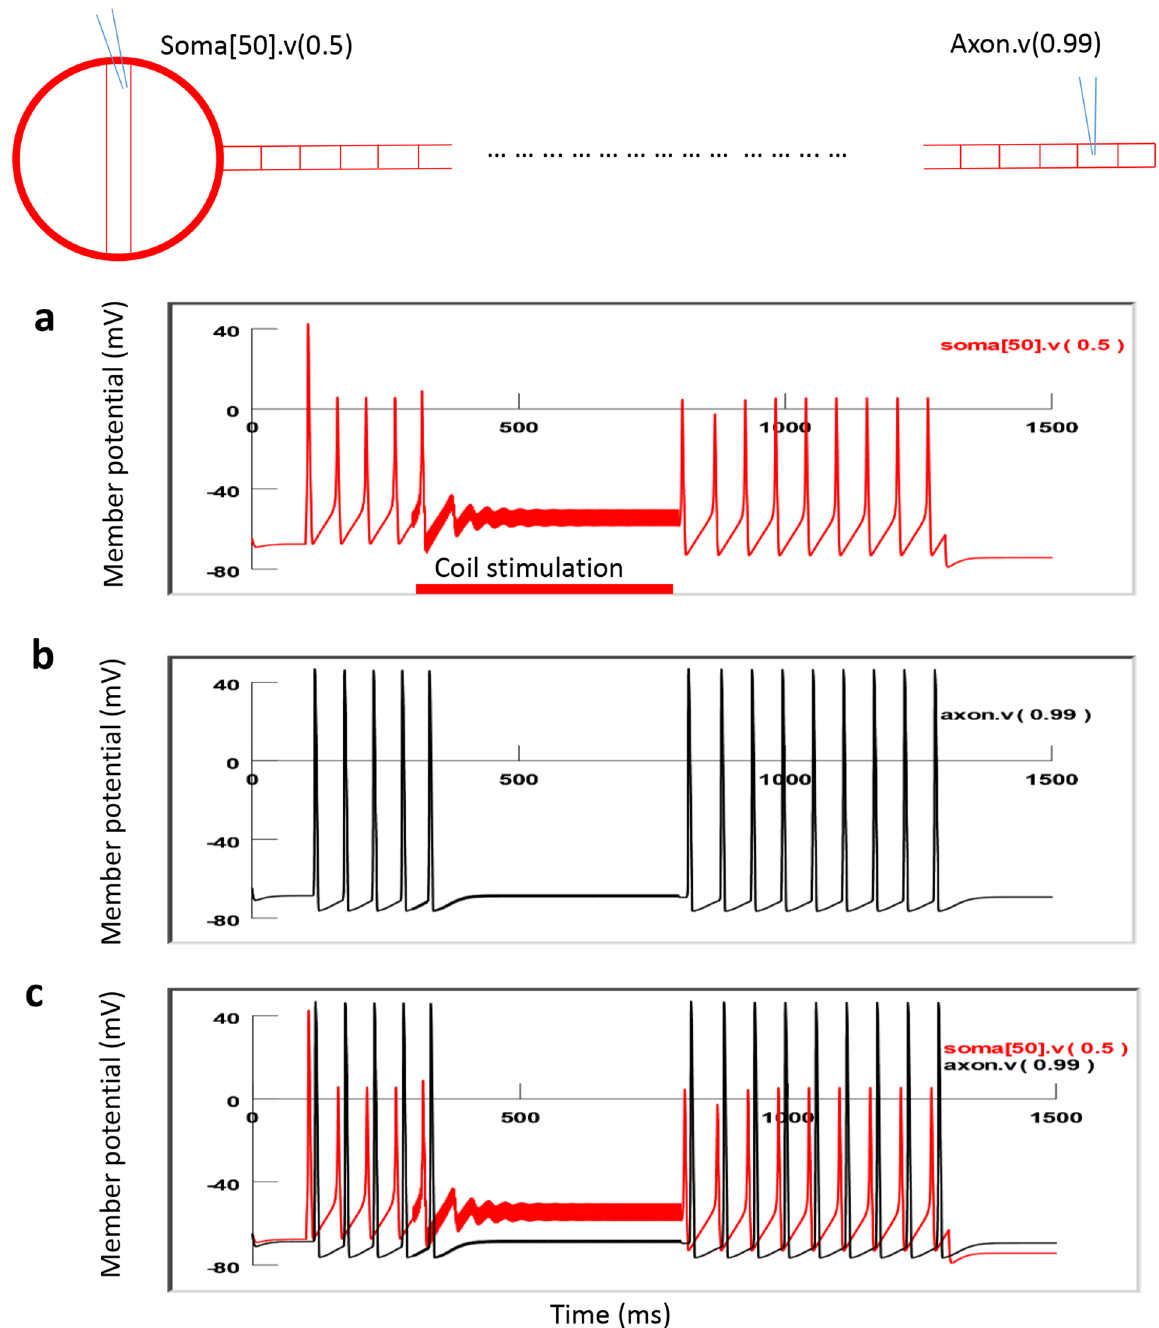
Figure 10. HFS with miniature magnetic coil inhibited soma activity and blocked neuron output in the modeled axon. The miniature coil was positioned at (− 1000, 300). A depolarization current was injected into the soma to trigger action potentials. A 500 ms train of biphasic square pulses (400 Hz) was applied to the coil, leading to the blockage of the action potentials in the soma. Activity recorded from the distal end of the axon was also eliminated. ( a ) Membrane potential recorded from the soma. ( b ) Membrane potential recorded from the distal axon. ( c ) Dual recording from the soma and the